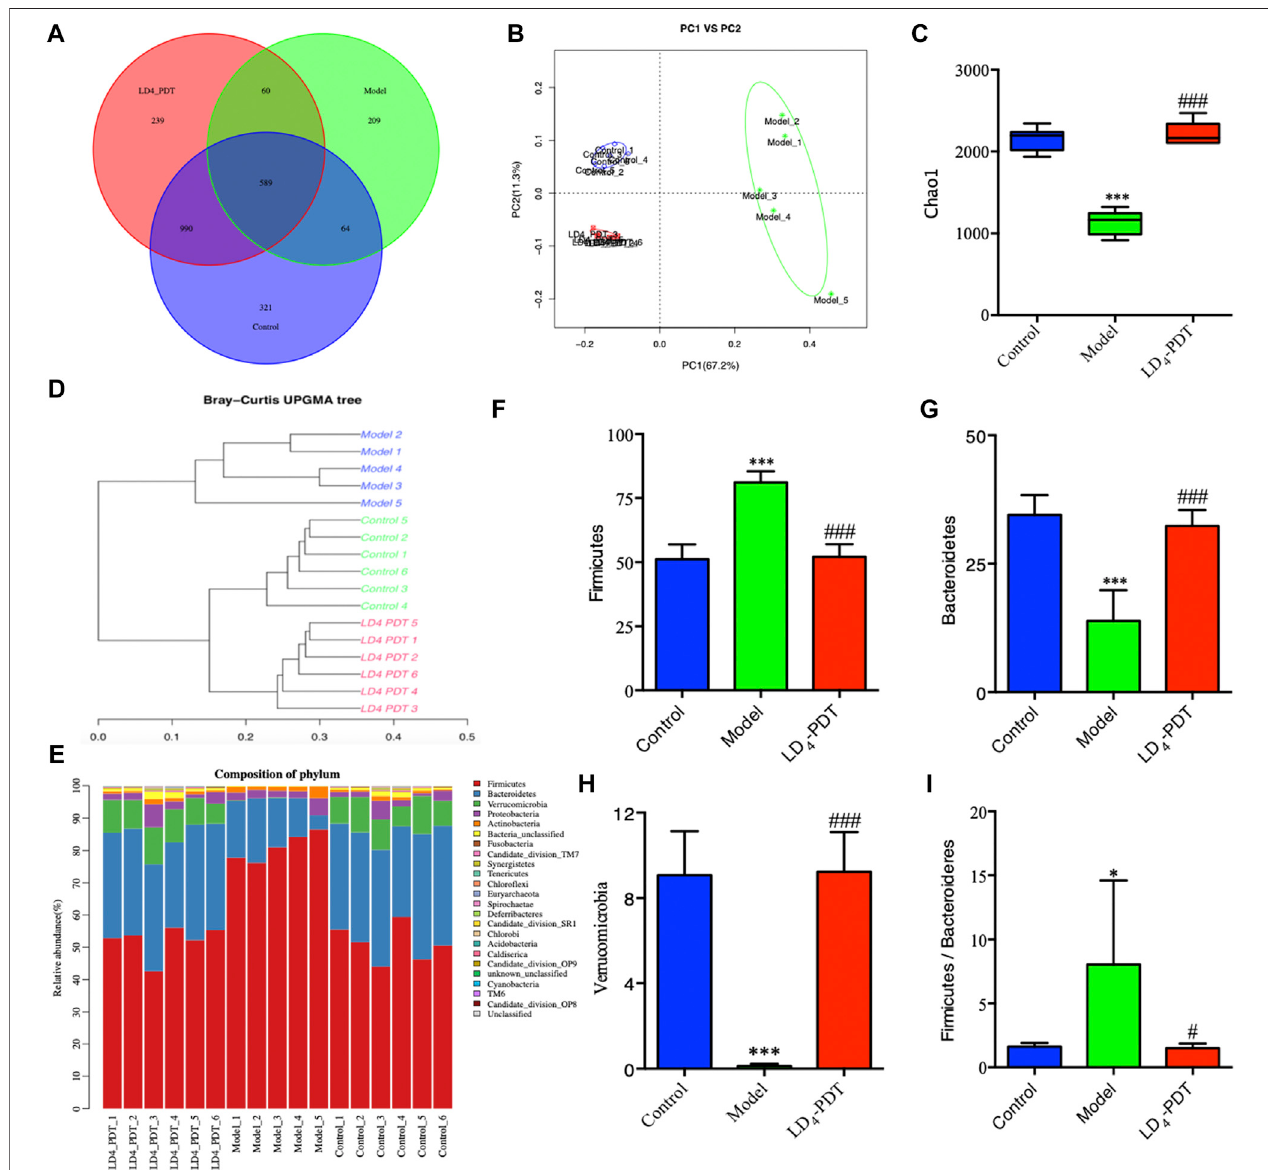
FIGURE 8 | LD 4 -PDT treatment altered the gut microbiota in TNBS-induced UC model rats. (A) Venn diagram indicated the differential numbers of OTUs in each group. (B) PCoA score. (C) Chao1 index represented the α -diversity of the gut microbiota. (D) Hierarchical clustering of fecal microbiota in the control, model and LD 4 - PDT groups. (E) Phylum-level distribution of fecal microbiota (F – H) Relative abundance of the (F) Firmicutes, (G) Bacteroidetes, (H) Verrucomicrobia (I) The Firmicutes/ Bacteroidetes (F/B) value ** p < 0.01 , *** p < 0.001 vs control group; # p < 0.05 , ## p < 0.01 , ### p < 0.001 vs model group; n (cid:2) 6 rats per group.